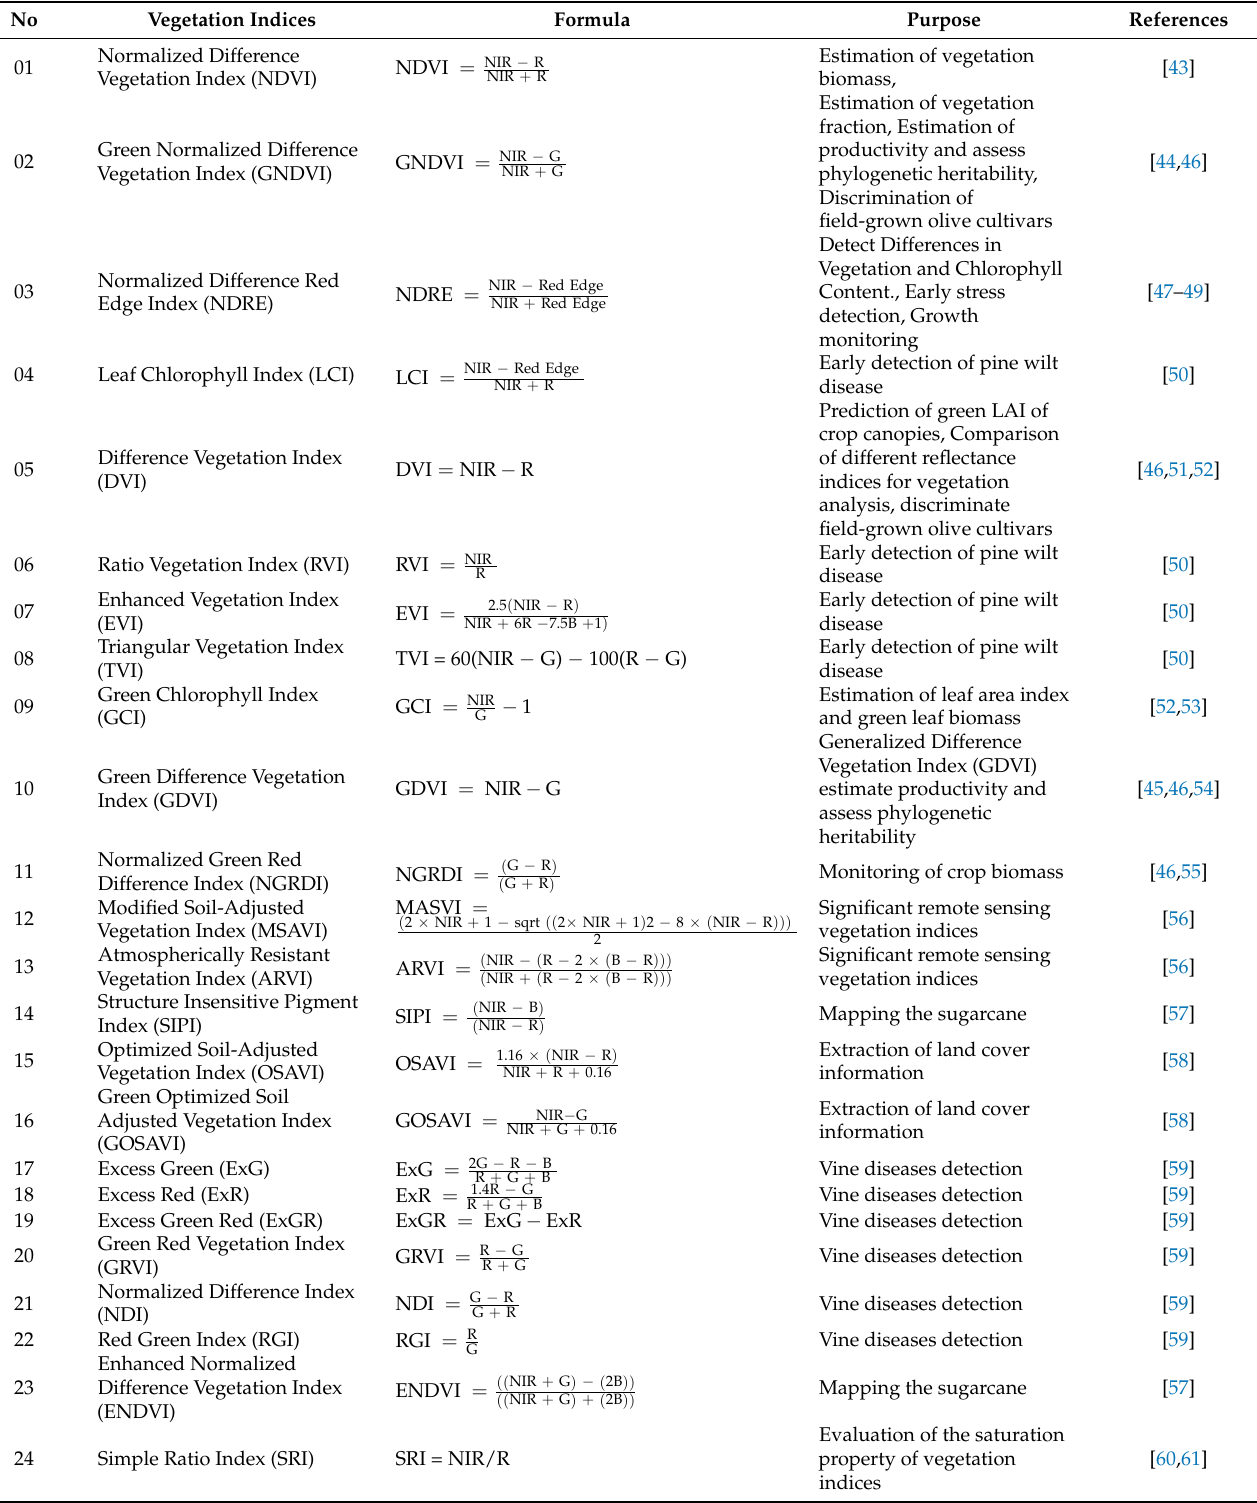
Table 5. Vegetation indices